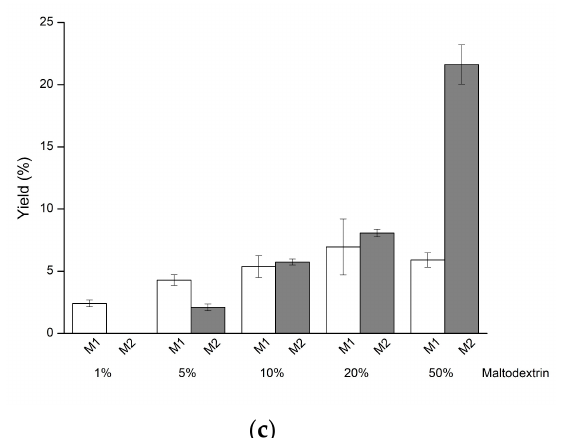
Figure 6. Effects of the sugar donor on the glycosylation of mangiferin by Pg MA. ( a ) Different sugar donors were used in the glycosylation of mangiferin. ( b ) HPLC analysis of the glycosylation mixture of mangiferin by Pg MA with 50% ( w / v ) maltodextrin. ( c ) Different maltodextrin concentrations were used in the glycosylation of mangiferin. The reaction was performed with 5.6 μ g/mL Pg MA, 1 mg/mL mangiferin, and the tested sugar donors at 50 mM of PB (pH 7) and 65 °C for 24 h. After the reaction, the reaction mixture was analyzed with HPLC. The conditions for HPLC are described in Section 2. The yield of the product was calculated by dividing the area of the product by that of mangiferin without an enzyme reaction (control reaction).